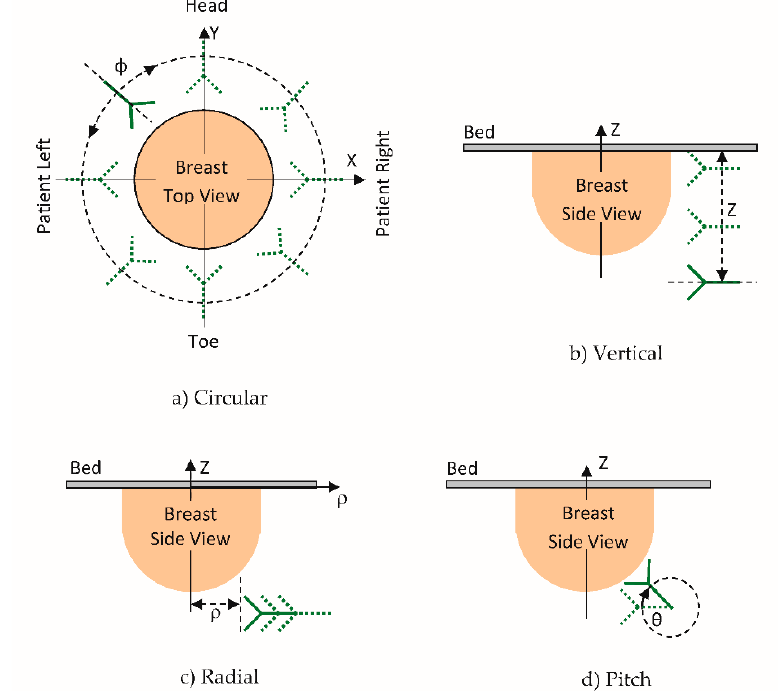
Figure 2. View of the different movement capability: ( a ) circular along Φ allowing rotation over a full revolution around the breast; ( b ) vertical along Z with travel from − 20 to − 178 mm below the examination bed; ( c ) radial along ρ , which can vary from 82 to − 28 mm, measured from the sensor tip and the center of the opening, and ( d ) pitch angle, defined by θ , adjustable between 0 and 88°.